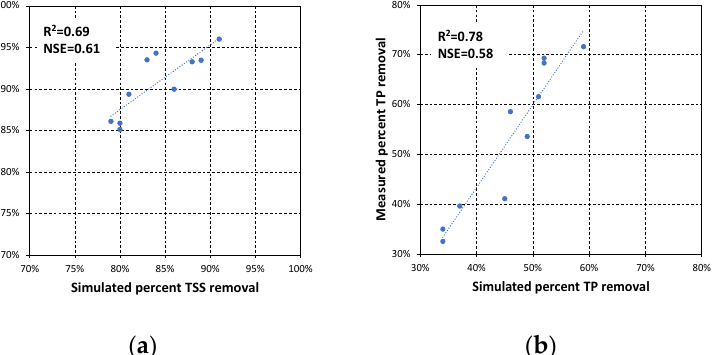
Figure 6. Scatter diagram of observed and simulated values for ( a ) percent TSS removal and ( b ) percent TP removal.